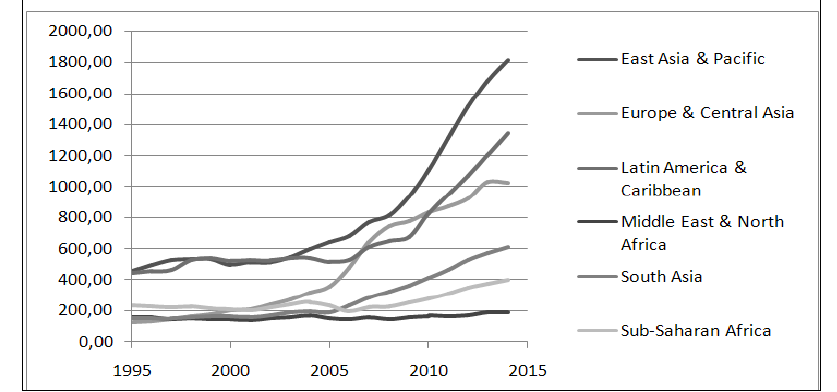
Fig. 1. Trends in total gross external debt region-wise